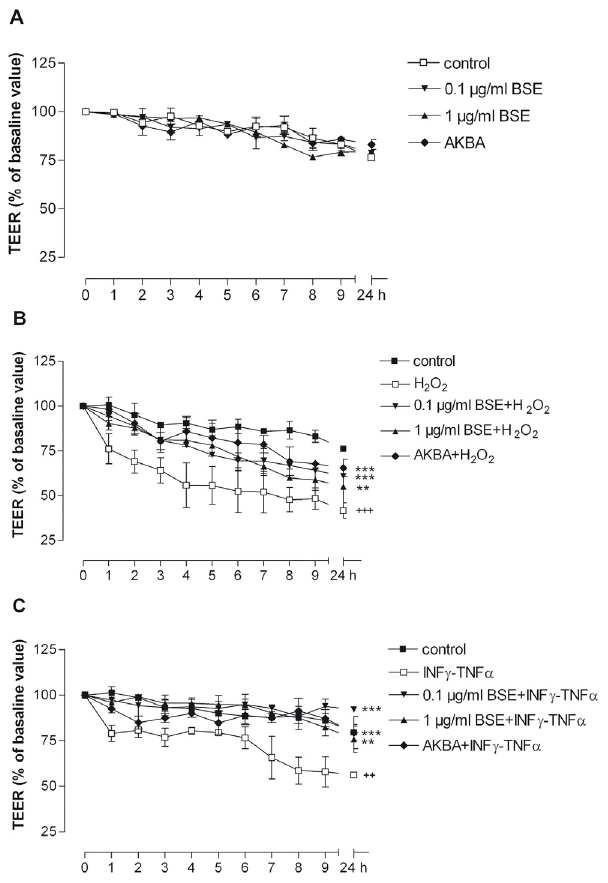
Fig 2. Effect of BSE and AKBA on transepithelial electrical resistance (TEER) in Caco-2 cell monolayers. A) BSE and AKBA; B) BSE and AKBA with H 2 O 2 ( +++ p < 0.001 H 2 O 2 vs control. *** p < 0.001 BSE and AKBA vs H 2 O 2 ** p < 0.01 BSE and AKBA vs H 2 O 2 ); C) BSE or AKBA with INF γ +TNF α ( ++ p < 0.01 INF- γ +TNF- α vs control *** p < 0.001 BSE and AKBA vs INF- γ +TNF- α ** p < 0.01 BSE and AKBA vs INF- γ +TNF- α ). Data are expressed as mean ± SEM percentage of baseline TEER value of n = 3